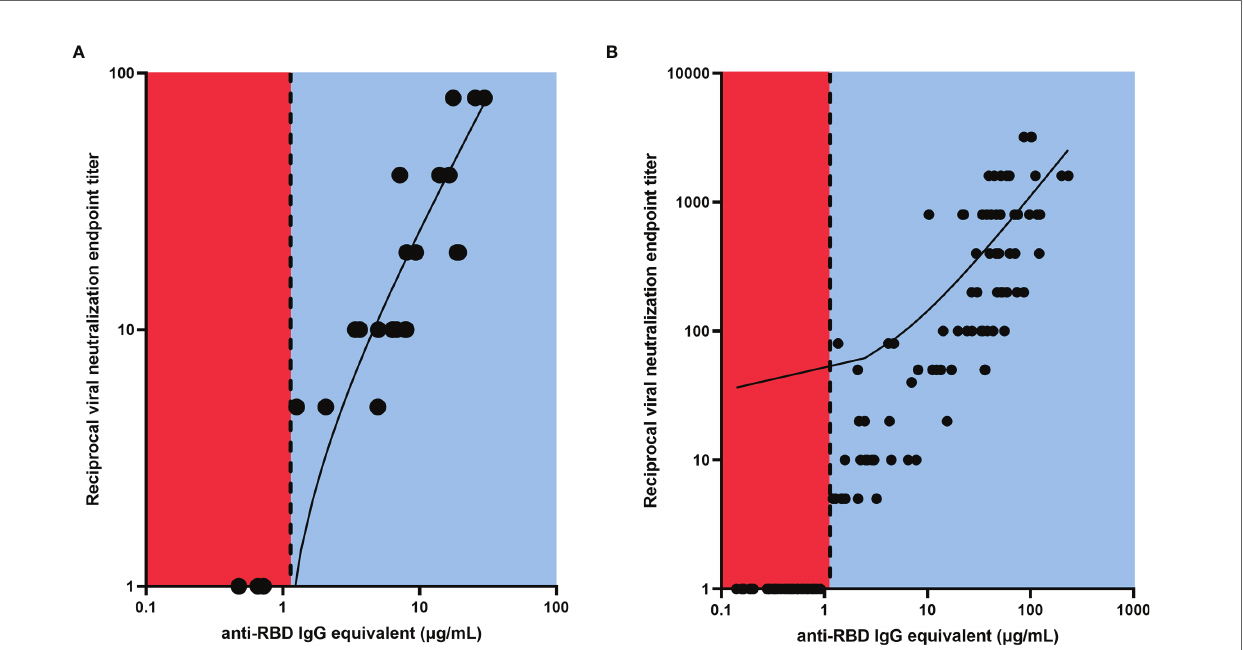
FIGURE 2 | Linear regression between RBD-binding IgG antibody concentration and reciprocal VN endpoint titer. There was a strong positive relationship between antibody binding and VN titer for (A) the validation cohort ( r = 0.9125, **** p < 0.0001), and (B) the SPARTA cohort ( r = 0.9359, **** p < 0.0001). The vertical dotted line represents the threshold between negative and positive antibody concentrations, determined by the ROC analysis. No participants below the threshold demonstrated any neutralizing activity, while all participants above the threshold showed some level of VN. In order to represent the values on a logarithmic scale, lack of neutralization was reported as